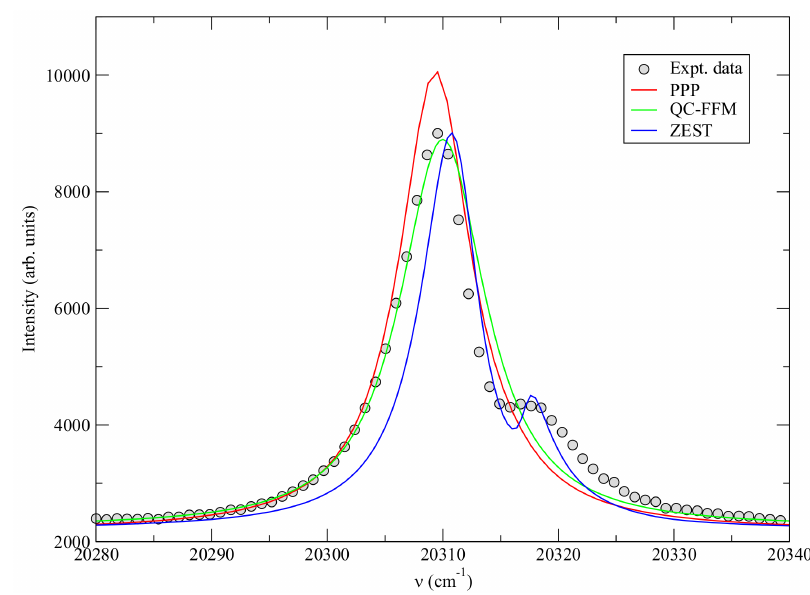
Figure 9. Preliminary comparisons of the helium 492 nm line profiles calculated by PPP, QC_FFM, and ZEST corresponding to a pressure P = 1.5